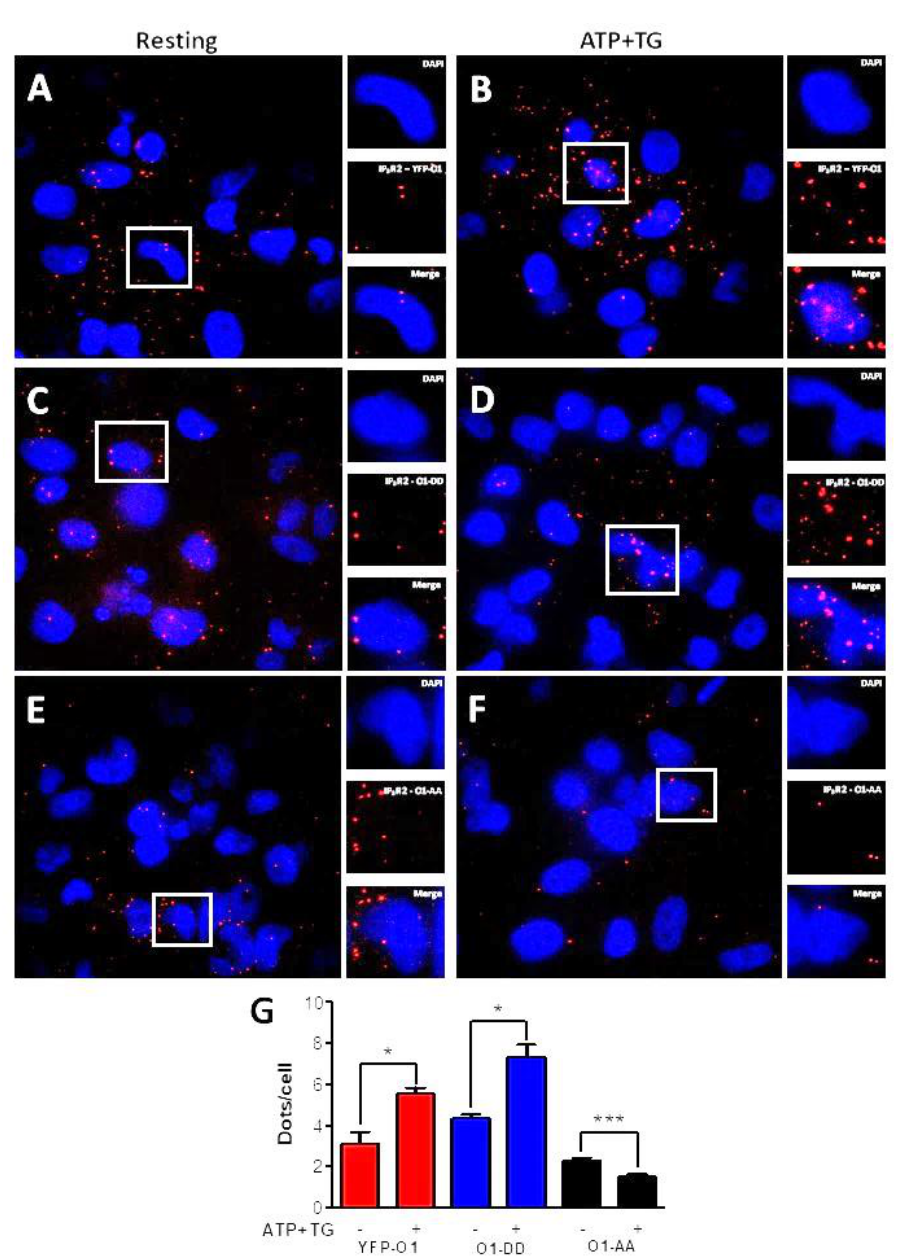
Figure 4. ATP and TG stimulate the interaction of IP 3 R2 with O1-wt and O1-DD, but inhibit the interaction of IP 3 R2 with O1-AA. A proximity ligation assay (PLA) was carried out in cells expressing either eYFP-Orai1, Orai1-S27D/S30D (O1-DD), or Orai1-S27A/S30A (O1-AA) for detecting their interaction with IP 3 R2. ( A ) Fluorescence images show nuclei stained with DAPI, and red dots represent positive PLA for IP 3 R2 and Orai1 for cells expressing eYFP-O1 at resting conditions or ( B ) after being stimulated with ATP (10 µM) and TG (1 µM) for 3 min. ( C , D ) Dot PLA images for cells expressing O1-DD channels at rest and after being stimulated with ATP and TG, respectively. ( E , F ) PLA images for cells expressing O1-AA channels at rest and after stimulation with ATP and TG, respectively. ( G ) The average number of red dots per nucleus as an indicator of the IP 3 R2–Orai1 interaction for cells overexpressing wild type Orai1 (eYFP-O1, red bars), phosphomimetic Orai1 (O1-DD, blue bars), and phosphorylation-resistant Orai1 mutant (O1-AA, black bars). Statistical analysis was carried out with an unpaired, one-tail Student’s t -test with the corresponding control. Bars show the mean ± SEM. * p < 0.05; *** p < 0.001 from at least 50 cells from three independent experiments.